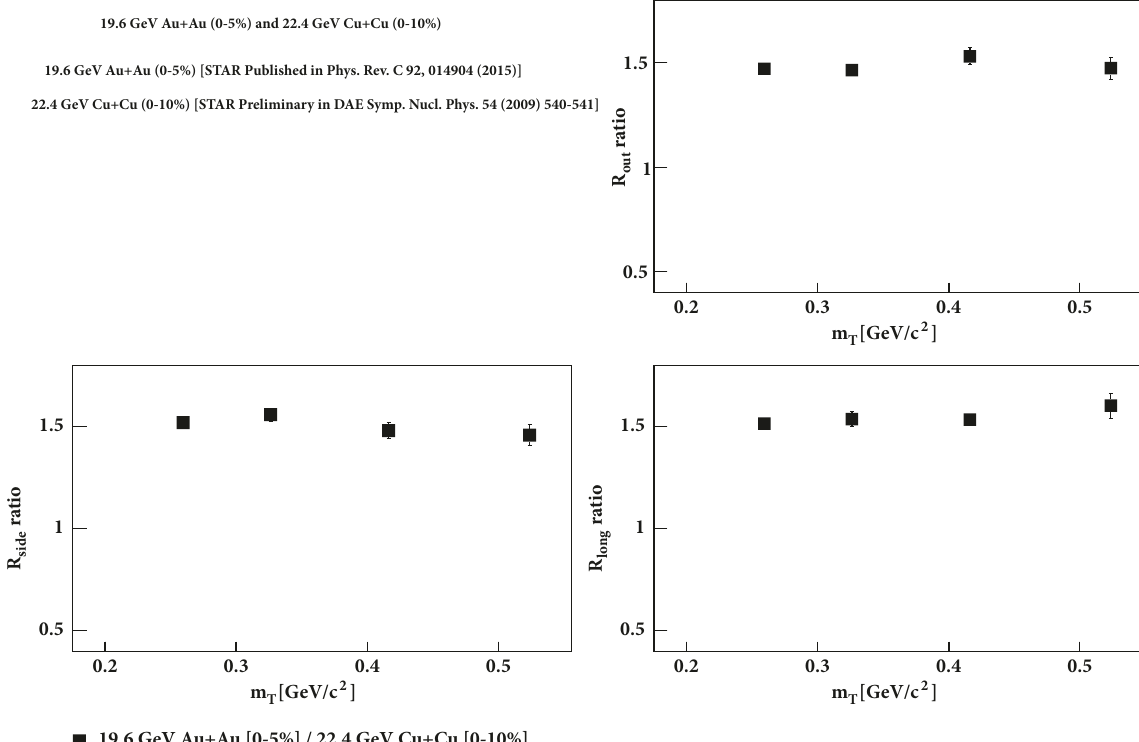
Figure 3: Ratios of HBT radii at top centralities for Au+Au and Cu+Cu collisions at √𝑠 NN = 19.6 and 22.4 GeV versus 𝑚 𝑇 . Only statistical errors are shown for Au+Au collisions at √𝑠 NN = 19.6 GeV and Cu+Cu collisions at √𝑠 NN = 22.4 for their top central